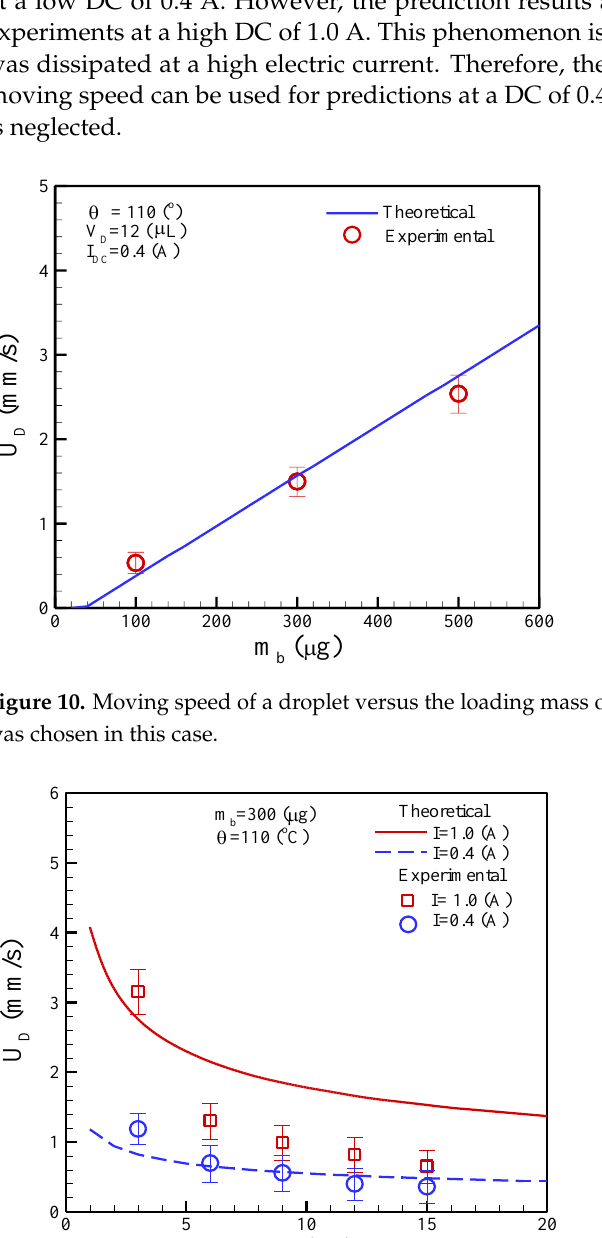
Table 3. Properties of materials.